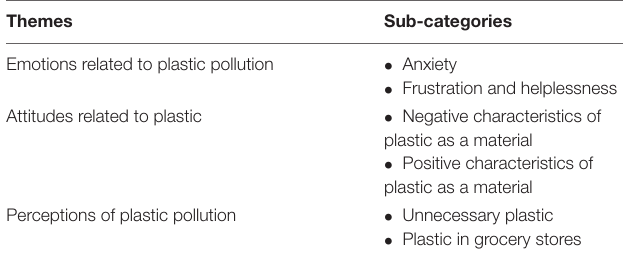
TABLE 2 | Overview over themes synthesized from the semi-structured